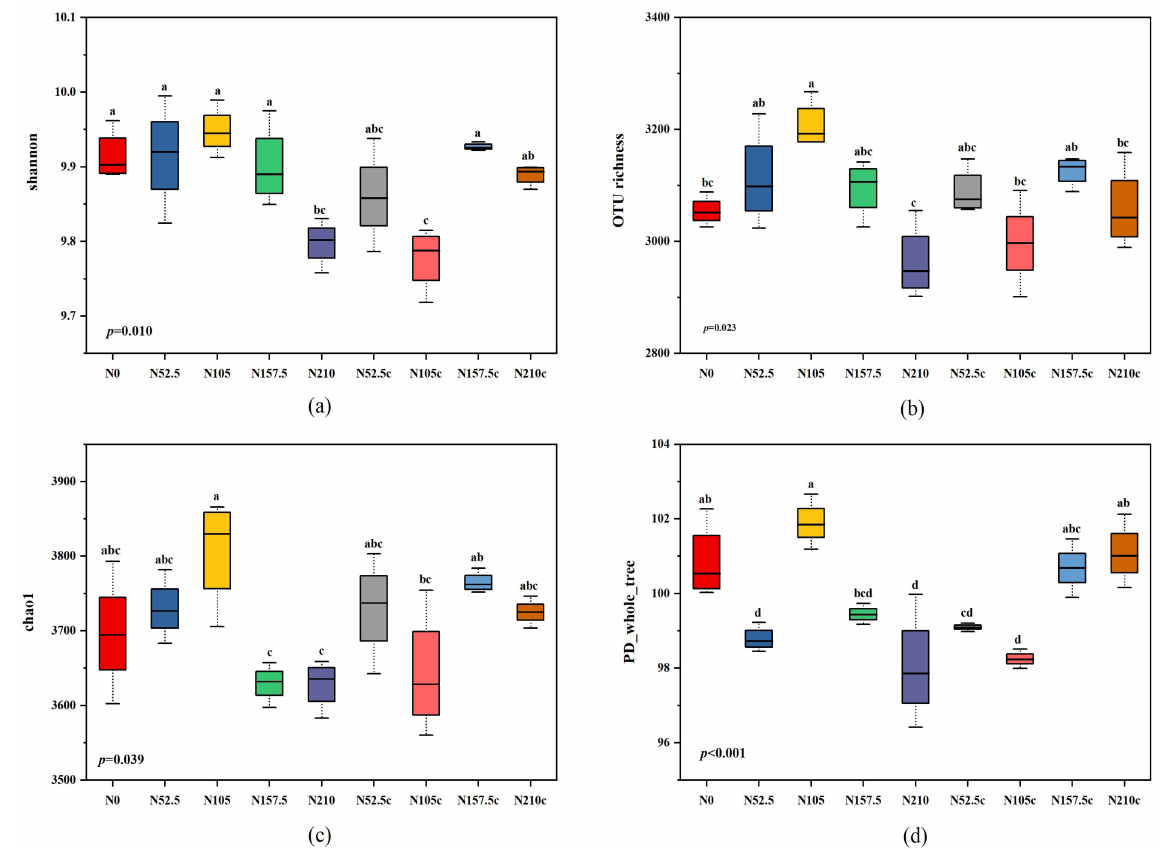
Figure 1. Alpha diversity analyses of Shannon ( a ), OTU richness ( b ), Chao1 ( c ), and PD_whole_tree ( d ) indexes. N0, 0 kg N ha − 1 year − 1 ; N52.5, 52.5 kg N ha − 1 year − 1 ; N105, 105 kg N ha − 1 year − 1 ; N157.5, 157.5 kg N ha − 1 year − 1 ; N210, 210 kg N ha − 1 year − 1 ; N52.5c, 52.5 kg N ha − 1 2 year; N105c, 105 kg N ha − 1 2 year; N157.5c, 157.5 kg N ha − 1 2 year; N210c, kg N ha − 1 2 year. Different letters above the boxes are significant at p <